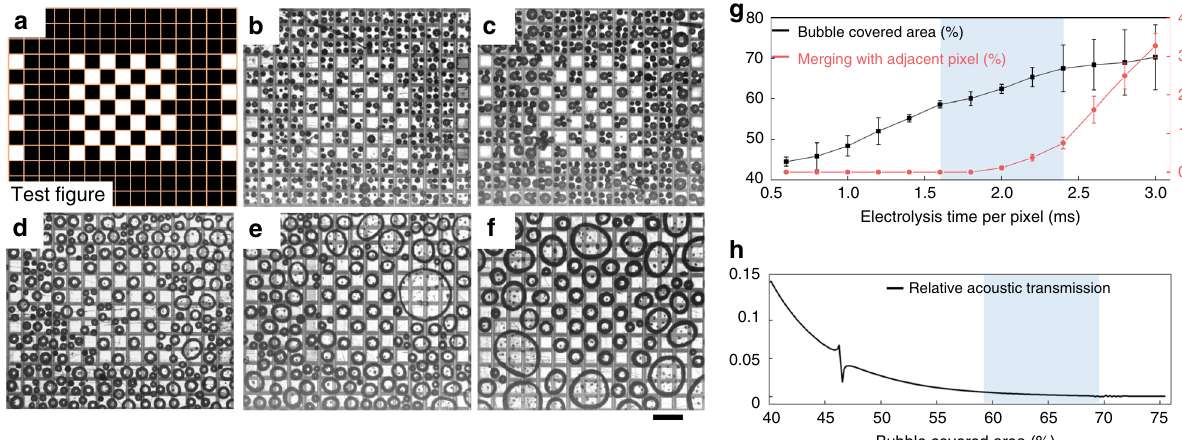
Fig. 3 Bubble evolution as a function of the time for electrolysis. a The test pattern, where the dark pixels mark areas that receive current, and white pixels that do not. Extending the duration of the electrolysis from ( b ) 0.6 ms, ( c ) 0.8 ms, ( d ) 1.6 ms, ( e ) 2.4 ms to ( f ) 2.8 ms, increases the size and the coverage of the bubbles. Merging of growing bubbles with those at adjacent pixels ( g ). The optimal electrolysis time range for the spatial ultrasound modulation (SUM) (marked blue) is thus somewhere between d and e , i.e., between 1.6 ms and 2.4 ms. h Simulation shows that this coverage results in the blocking of 99% of the acoustic intensity. The scale bar is 200 μ